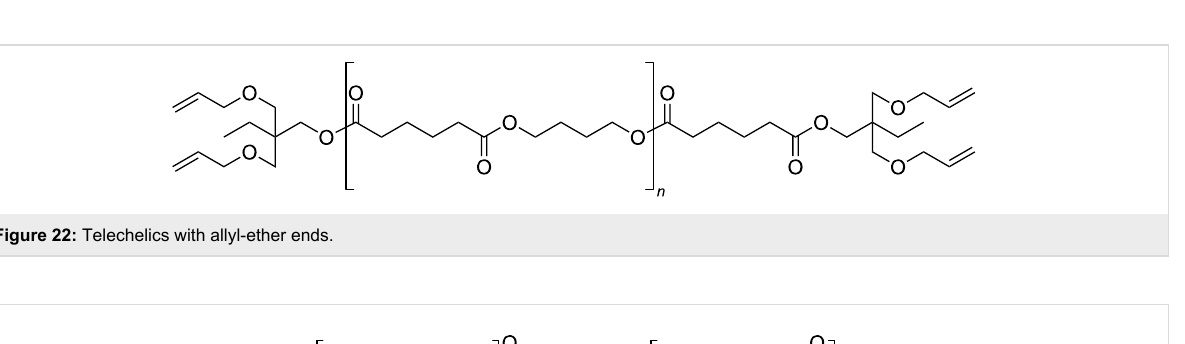
Figure 21: Telechelics with methacrylate ends.